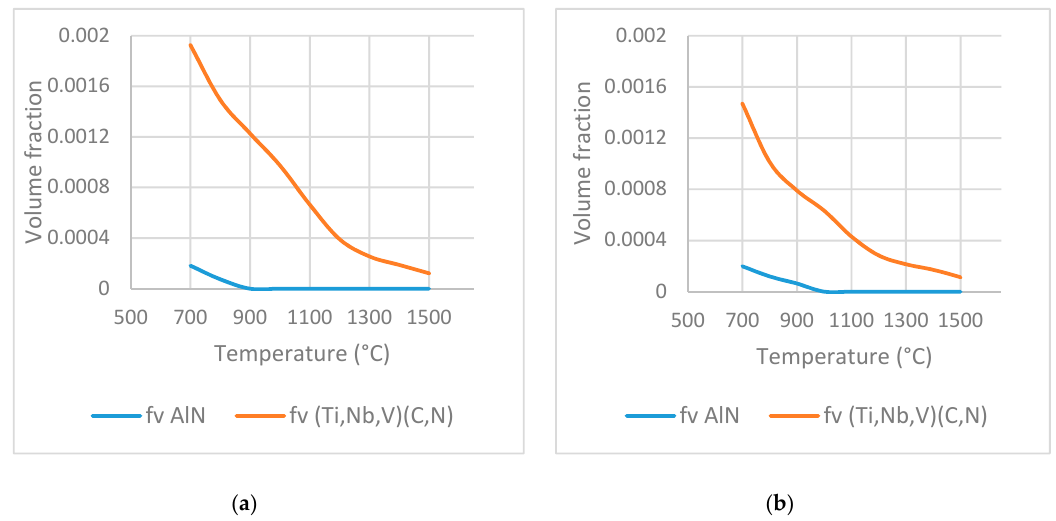
Figure 2. The calculated volume fraction of precipitates considering mutual solubility: ( a ) high-Nb steel; ( b ) low-Nb steel.